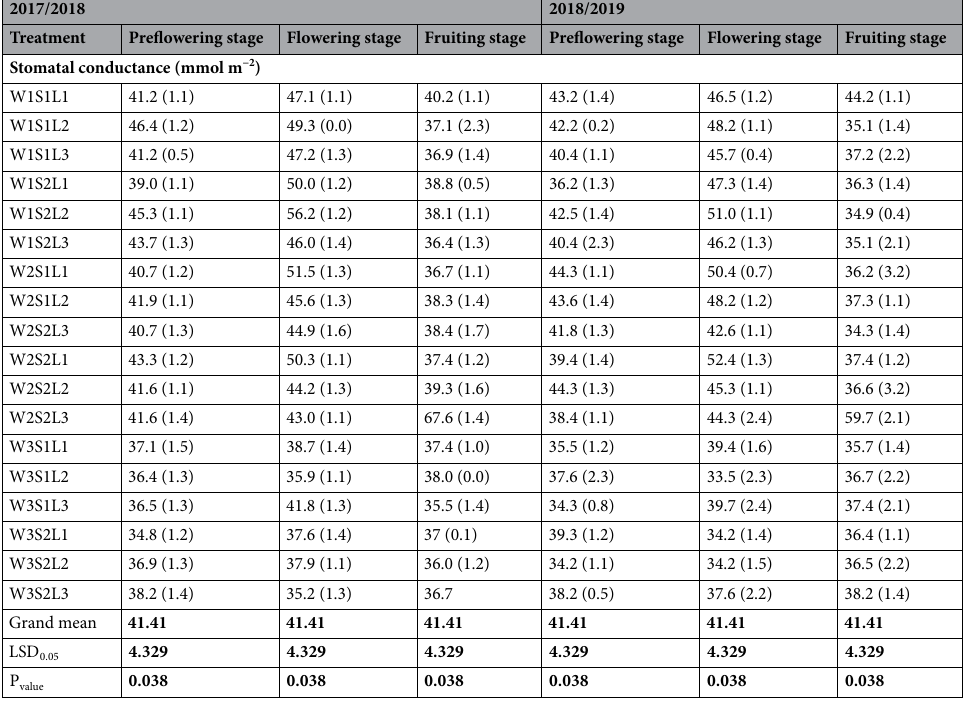
Table 2. Treatment interaction effect on the stomatal conductance (mmol m -2 ) of African horned cucumber. Treatment interaction effect on the stomatal conductance of African horned cucumber. W1 no water stress, W2 moderate water stress, W3 severe water stress, S1 loamy soil and S2 means sandy loam, L1 greenhouse, L2 shade net, L3 open field, WUE water use efficiency. Numbers in brackets represent the standard deviations of the mean. LSD 0.05 is the least significant difference of means. Years (seasons one—2017/18 and season two—2018/2019). P values in bold are lower than